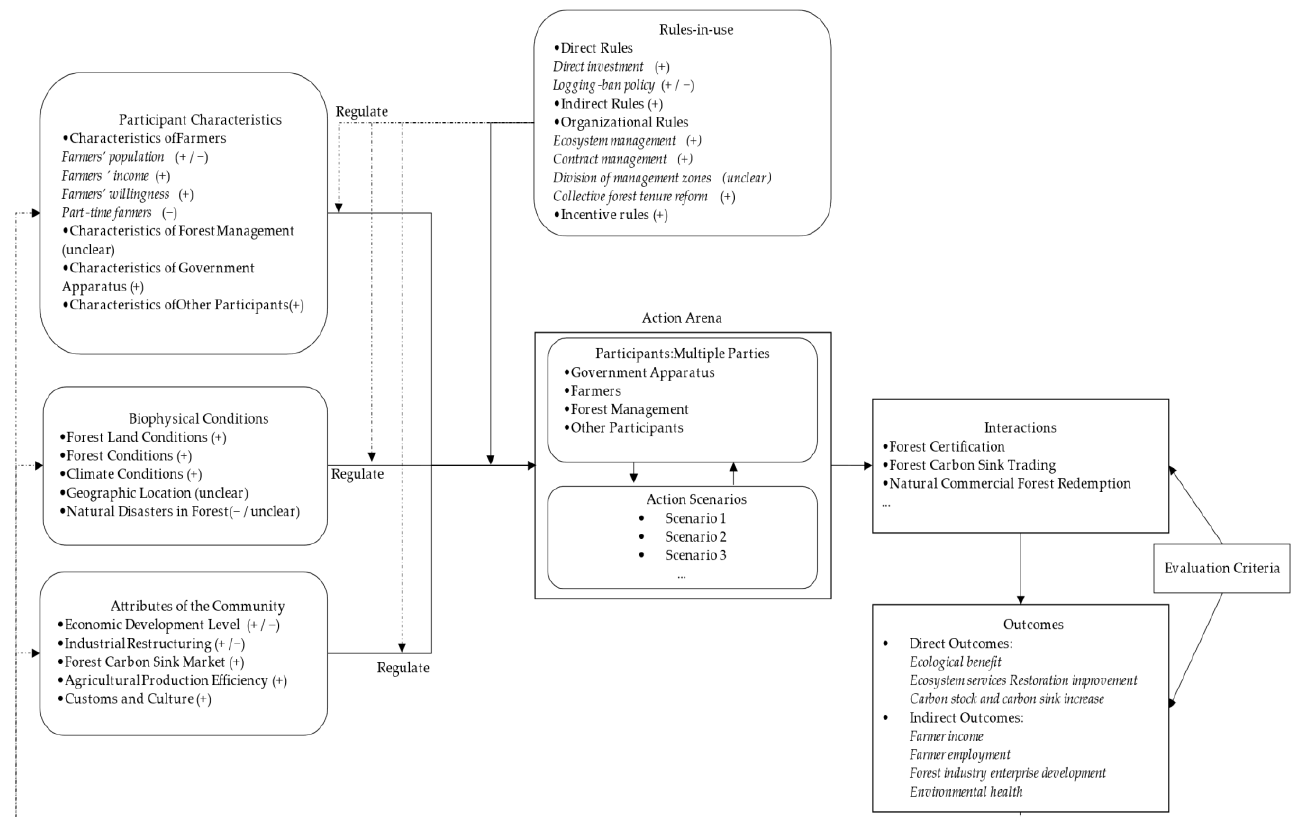
Figure 4. The mechanism for the participation of multiple parties in NFPR.